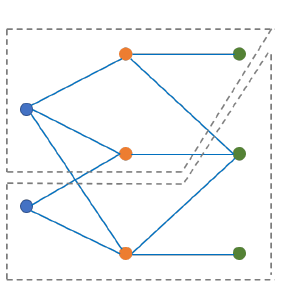
Fig. 2 An example of tripartite graph co-clustering